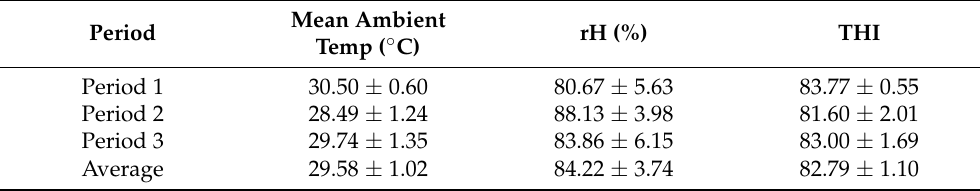
Table 2. Temperature–humidity index (Mean ± SD) of the experimental periods. Mean Ambient rH (%) THI Period Temp ( ◦ C) Period 1 30.50 ± 0.60 80.67 ± 5.63 83.77 ± 0.55 Period 2 28.49 ± 1.24 88.13 ± 3.98 81.60 ± 2.01 Period 3 29.74 ± 1.35 83.86 ± 6.15 83.00 ± 1.69 Average 29.58 ± 1.02 84.22 ± 3.74 82.79 ±